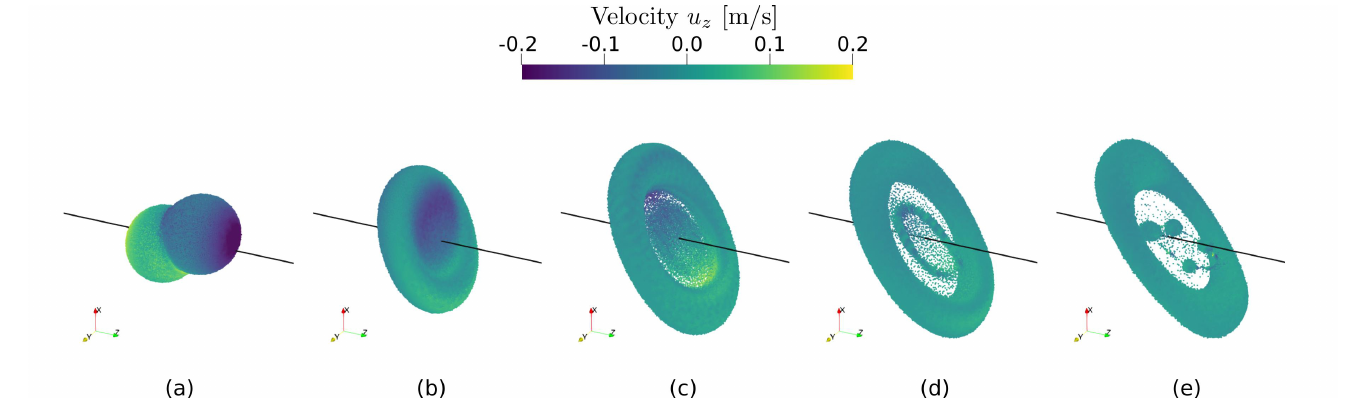
Figure 16. Droplet collision for Re = 550, We = 180, and ρ 1 : ρ 2 = 2 : 1 at ( a ) t = 1 s, ( b ) t = 5 s, ( c ) t = 11.25 s, ( d ) t = 15 s, and ( e ) t = 25